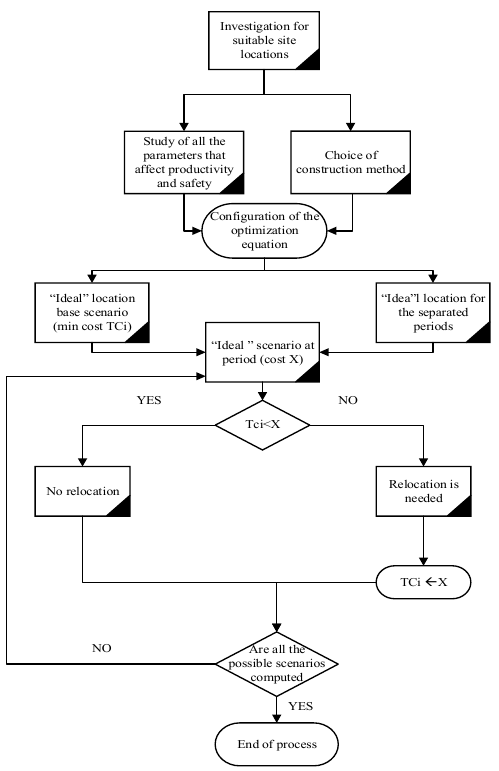
Figure 3. Optimization algorithm .